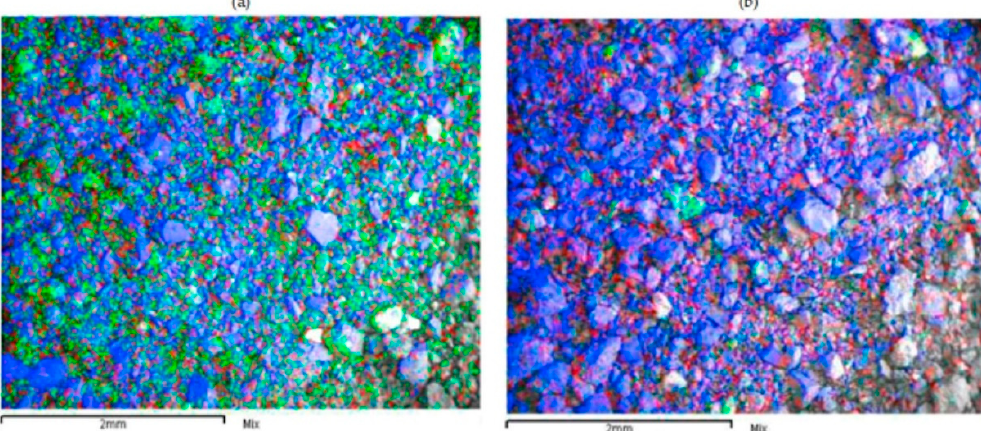
Figure 12. SEM image shows LB residues obtained under standard conditions ( a ) and with FeSO 4 as a reducing agent ( b ). Manganese (green), copper (red) and silica (blue).